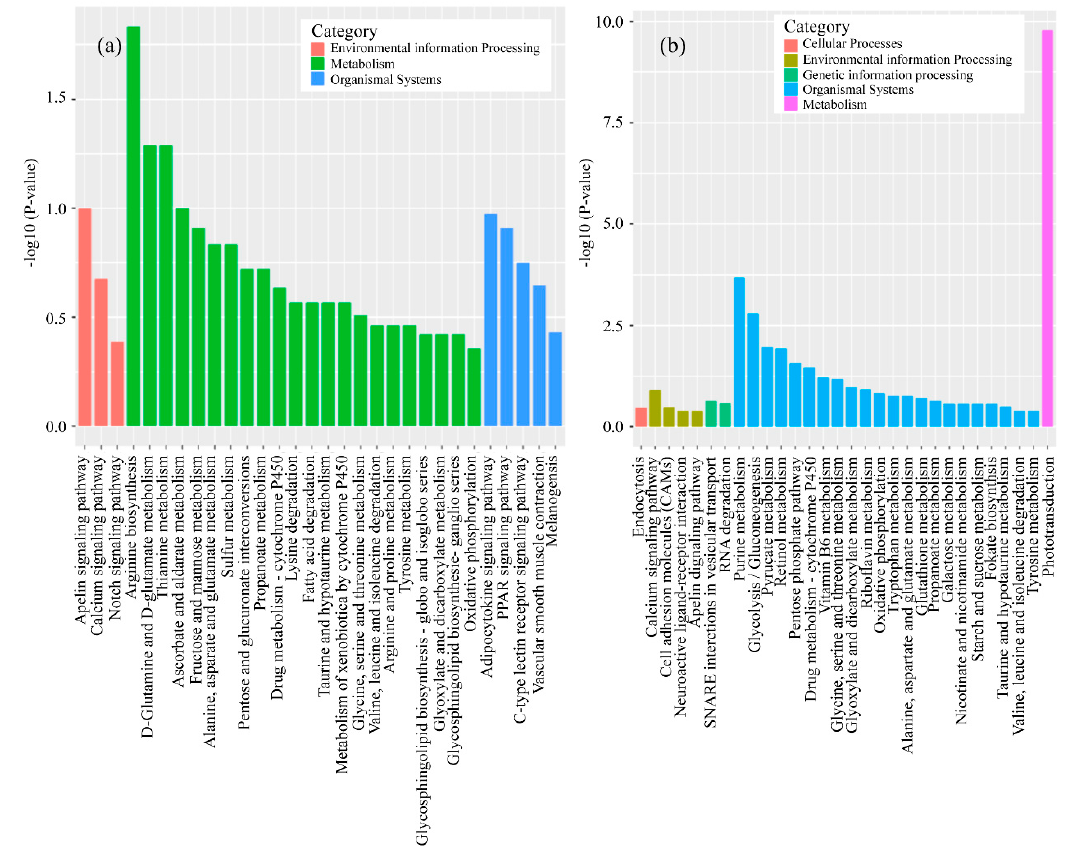
Figure 7. The top 20 enriched KEGG pathways in the erythromycin-treated groups and the control group ( a ) D. rerio , ( b ) O. latipes . Int. J. Environ. Res. Public Health 2020 , 17 , x FOR PEER REVIEW